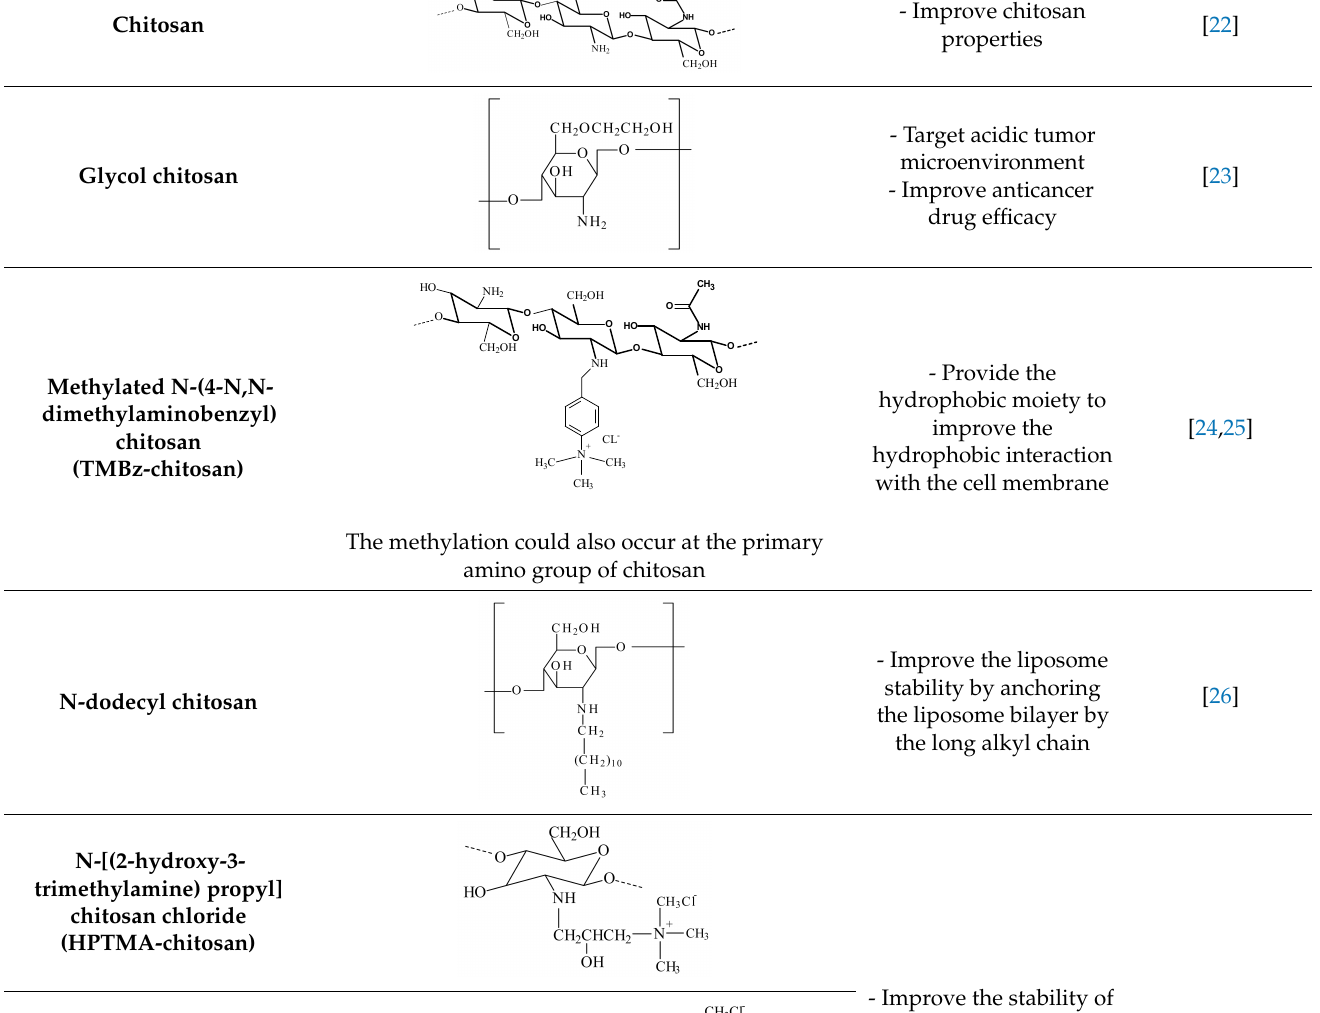
Table 1. Chemical structures of chitosan and its derivatives and role of chitosan modification in liposome coating. Chitosan Derivatives